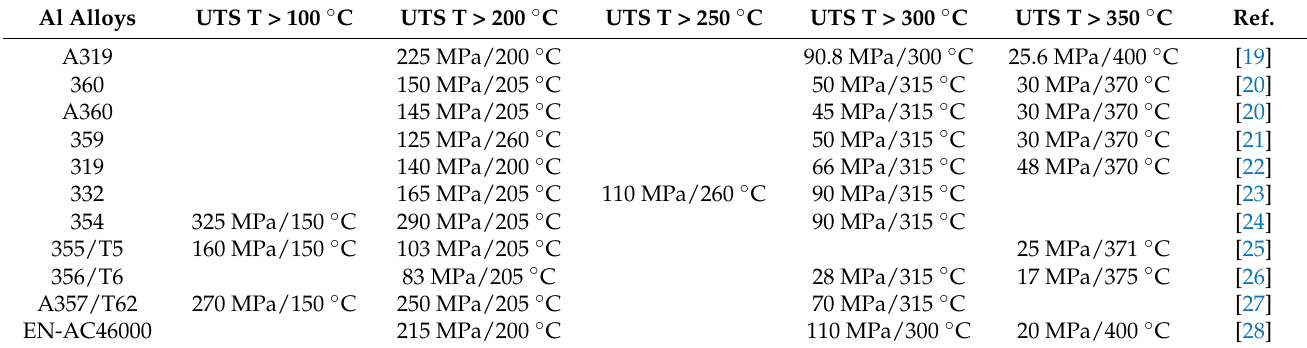
Table 1. Conventional Al alloys and their high-temperature